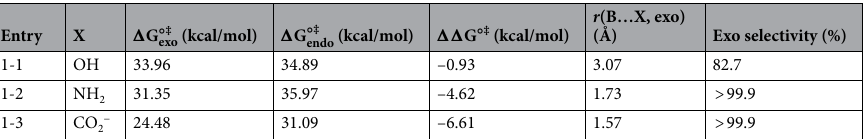
Table 1. Results of the DFT calculations on the TSs of the three DA reactions outlined in Fig. 1.